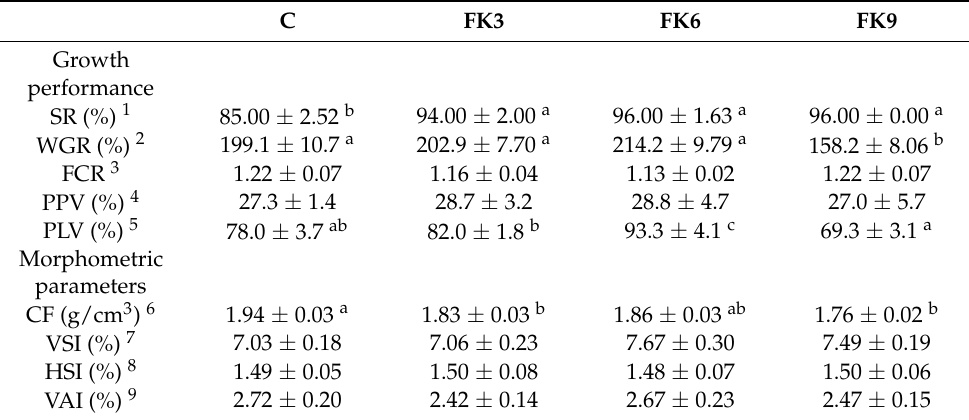
Table 4. Growth performances and morphometric parameters of largemouth bass fed diets with various FK levels (means ± SEM, n = 4).